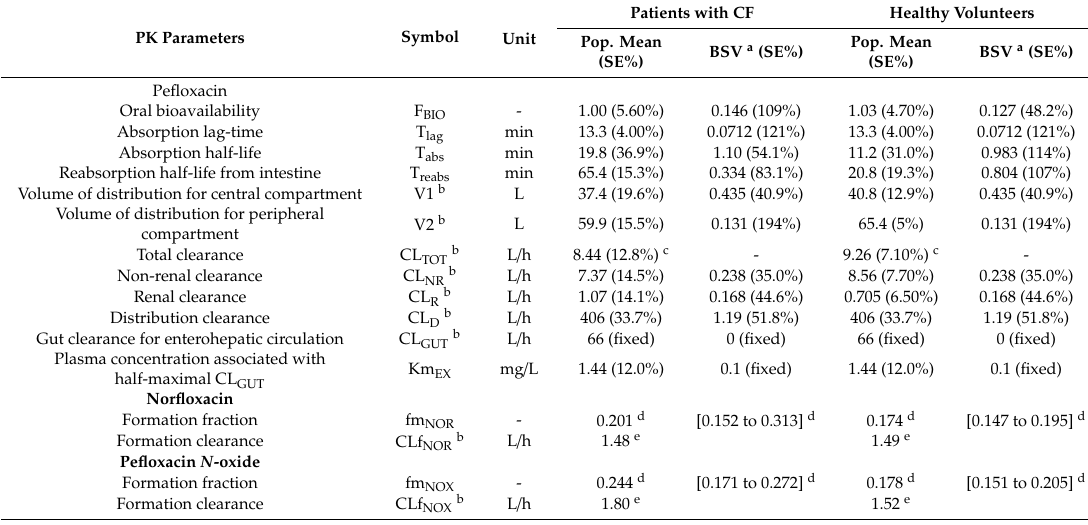
Table 3. Population PK parameter estimates for pefloxacin, norfloxacin and pefloxacin N -oxide in patients with CF and healthy volunteers for a model with allometric scaling by FFM.